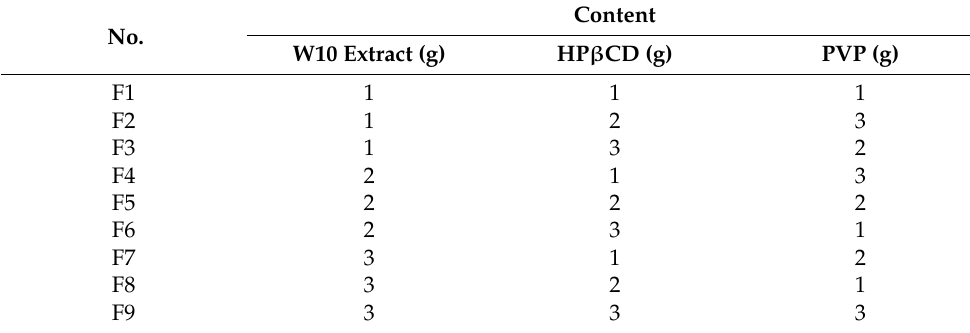
Table 2. Factorial Electrospinning Process Experiment